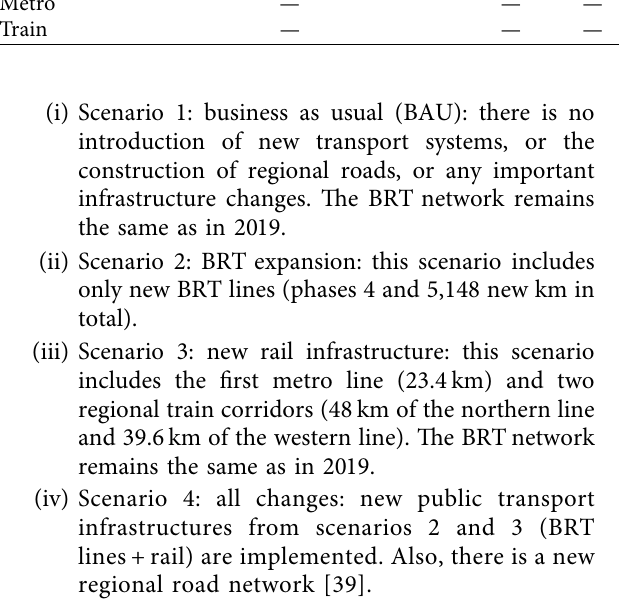
Alternative 2019 mobility survey modal split (%)